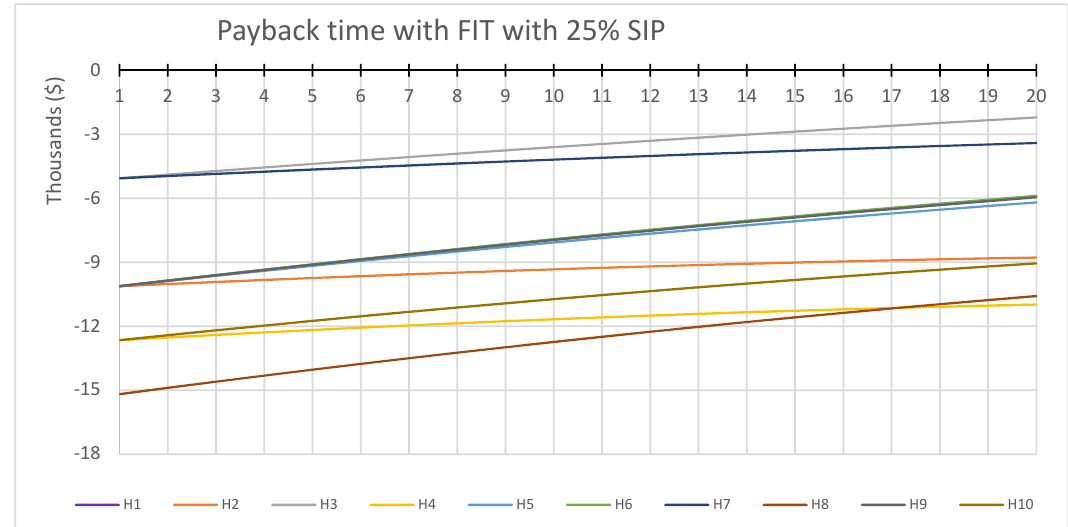
Figure 5. Economic model results demonstrating the payback time for the rooftop PV systems with feed-in tariff (FIT) with 25% Solar Incentive Programs (SIP) for houses H1:H10.